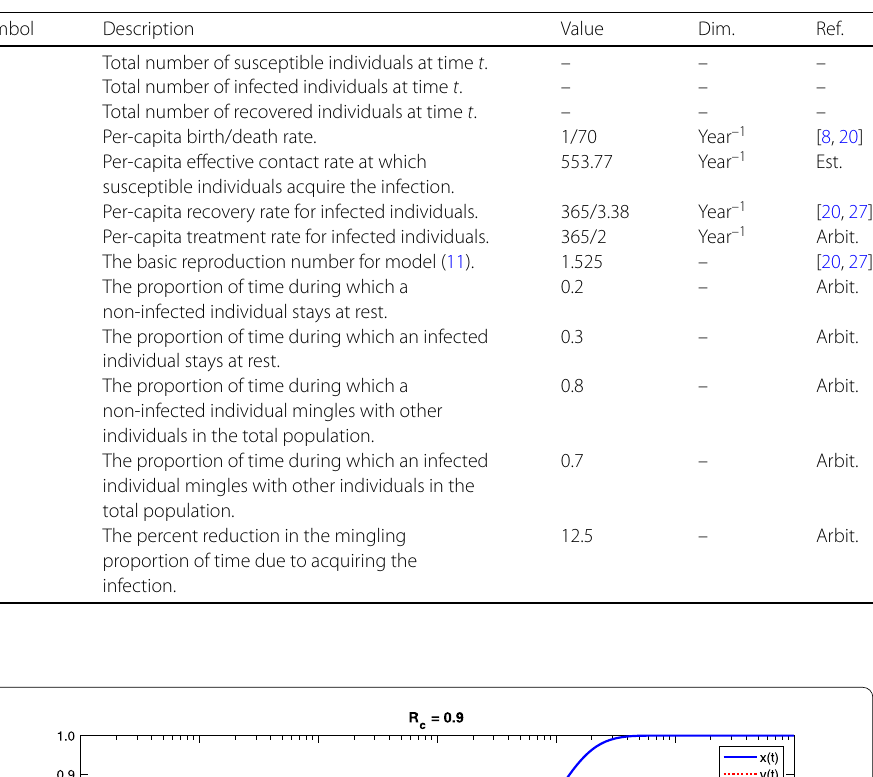
Table 1 Physical meaning, value, dimension and references for model states and parameters. (Dim. = Dimension, Ref. = References, Est. = Estimated, Arbit. = Arbitrary)